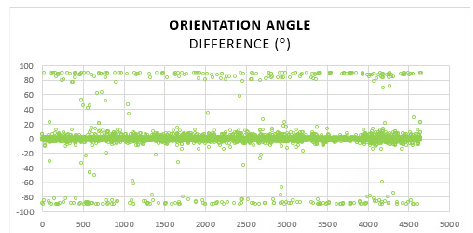
Fig. 9. Scatterplot of the orientation